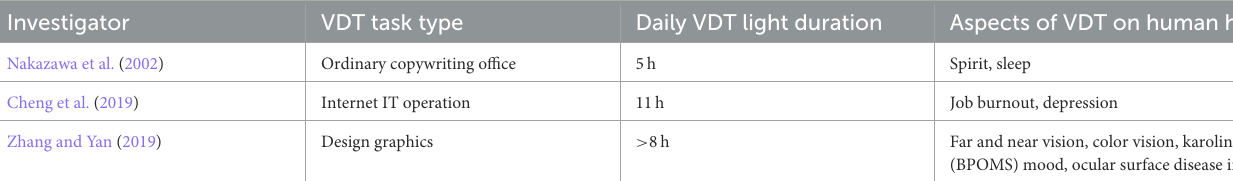
TABLE 3 Effect of VDT illumination duration on human